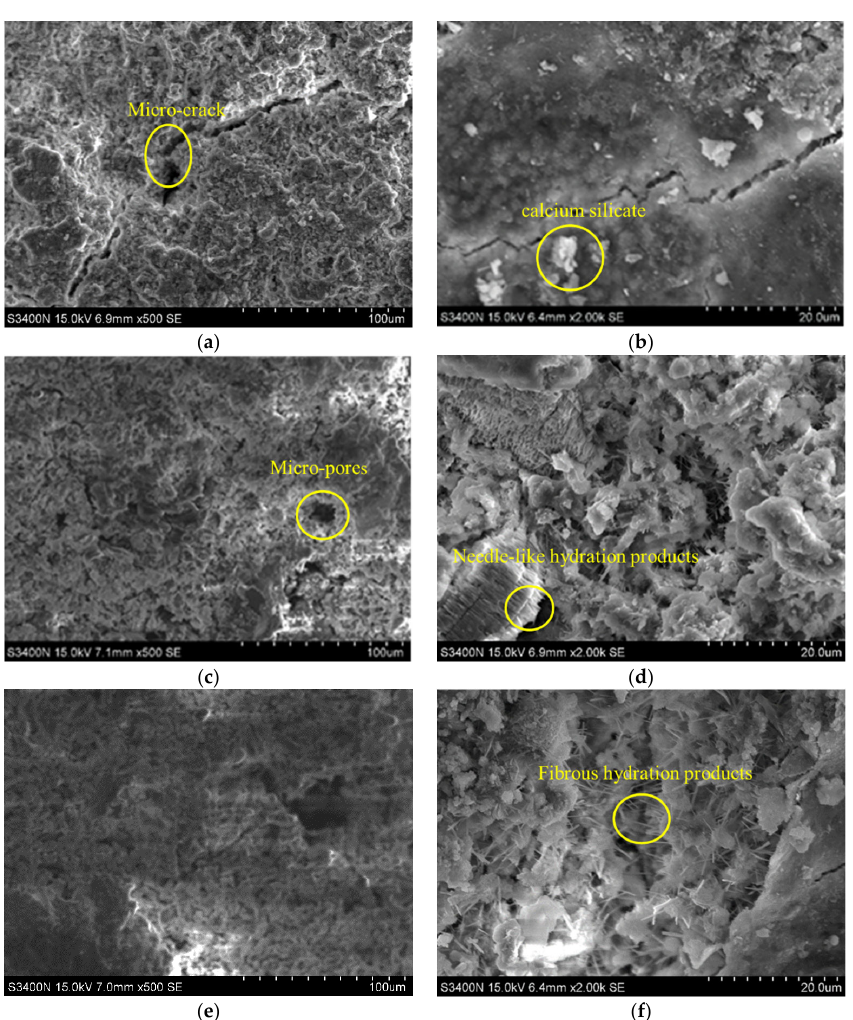
Figure 6. SEM image of concrete sample. ( a ) J0 (×500); ( b ) J0 (×2000); ( c ) G0 (×500); ( d ) G0 (×2000); ( e ) Y1 (×500); ( f ) Y1 (×2000). ( e ) Y1 ( × 500); ( f ) Y1 ( ×